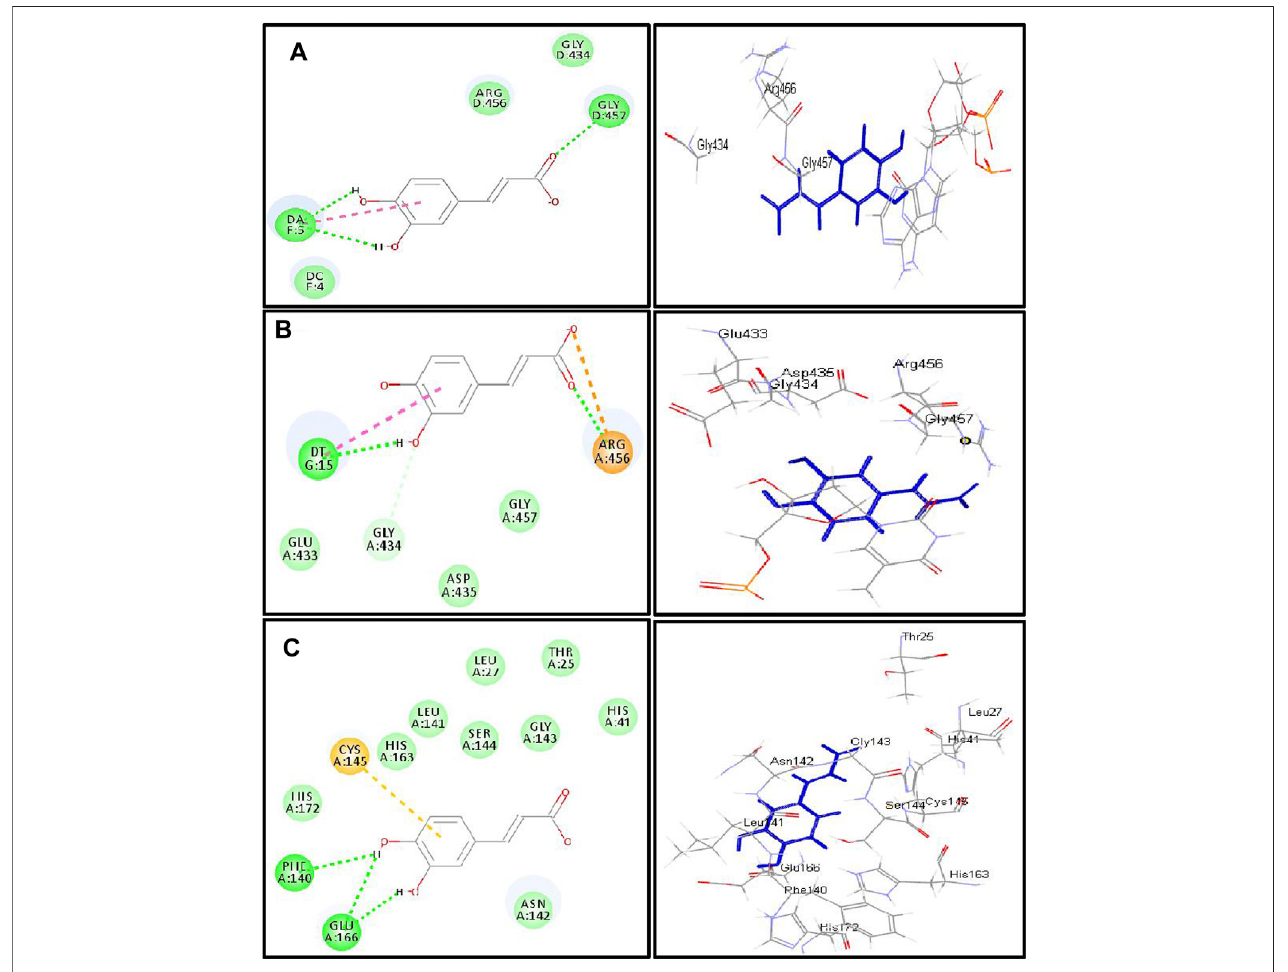
FIGURE4| 2D and 3D binding modes ofcaffeic acid inthe active centersof (A) DNA-gyrase, (B) topoisomeraseIV,and (C) SARS-CoV-2 M Pro ; dotted green lines indicate H-bonds; dotted light green lines indicate C-H-bonds; dotted purple lines indicate π -bonds; dotted orange bonds indicate salt bridge formation.